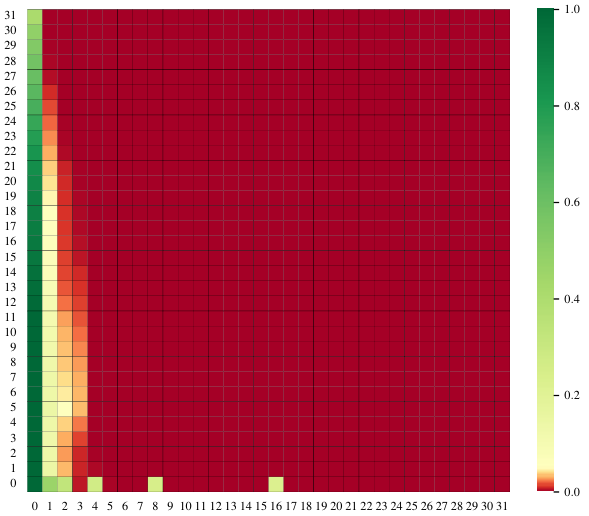
Figure 7. Empirical probability of surviving the sorting step h j for candidates j in Rate-1 nodes with L = 32 and P =